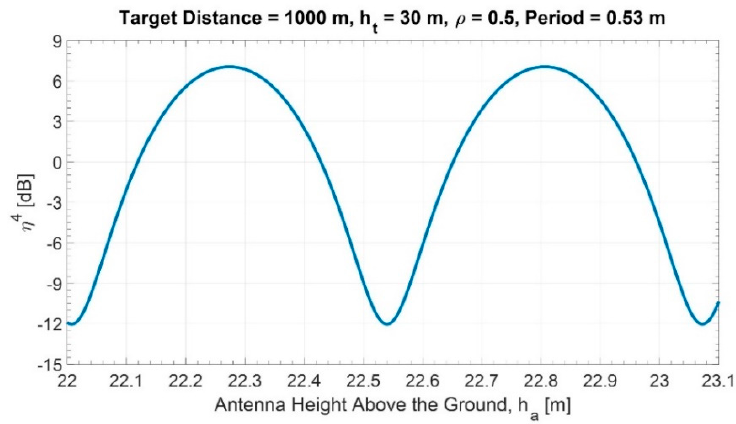
Figure 3. Multipath factor 𝜂 (cid:2872) vs. the antenna height (target distance D = 1000 m and target height of ℎ (cid:3047) = 30 m ). The period (cid:3090)(cid:3005) is equal to 0.53 m (cid:2870)(cid:3035) (cid:3295)